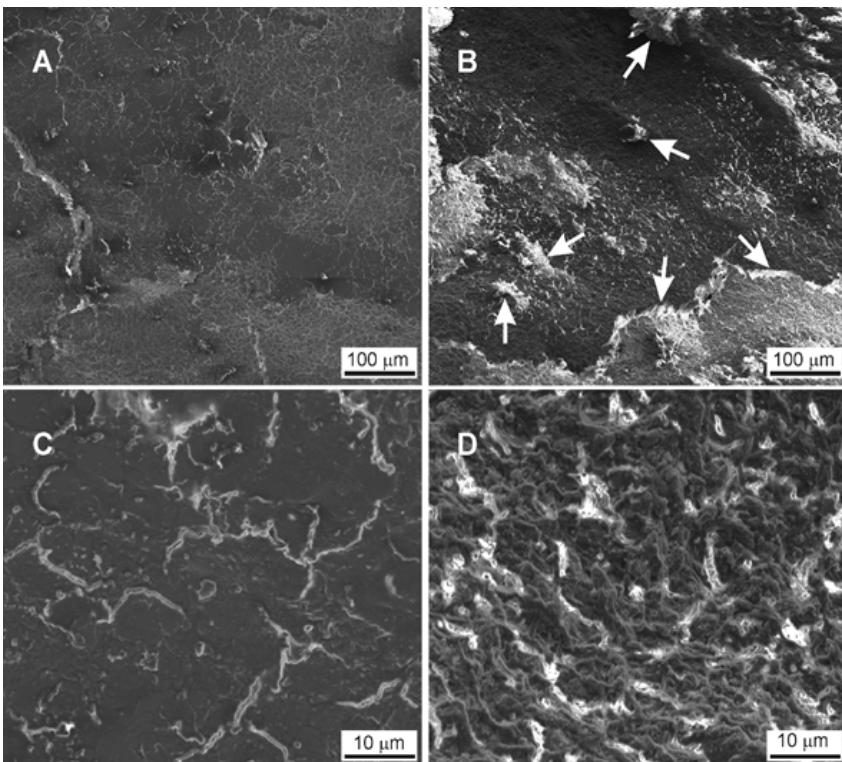
Figure 4. Analysis of tooth surface after laser ( A , C ) and drill ( B , D ) preparation.